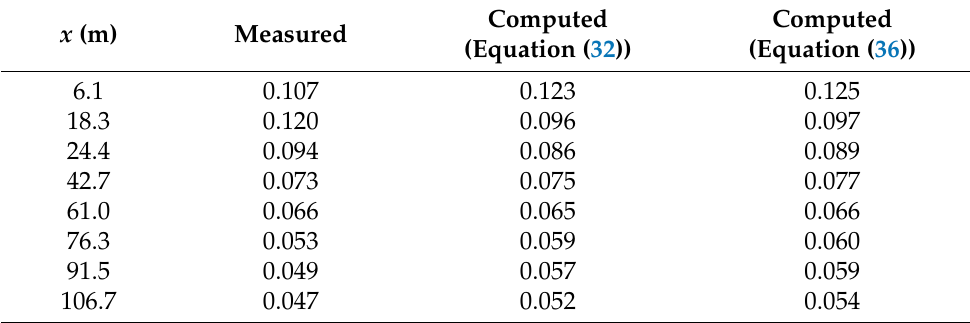
Figure 5. Computed surface displacements at four stations along the wave tank in Su’s experi- ments [42] on short-wave packets. The parameters are γ = 0.0868, ε = 0.09, ω 0 / ( 2 π ) = 0.96 Hz. Predictions from our model (blue line) and the spatial form of the classical Dysthe’s equation (red line) are compared. The positions x of the probes are 18.3 m, 42.7 m, 91.5 m, 106.7 m. Table 1. Measured and computed maximum local steepness k 0 A m at eight stations along the wave tank in Su’s experiments [43] on short-wave packets. The parameters are γ = 0.0868, ε = 0.09, ω 0 / ( 2 π ) = 0.96 Hz. Predictions from our model (third column) and the spatial form of the classical Dysthe’s equation (fourth column) are